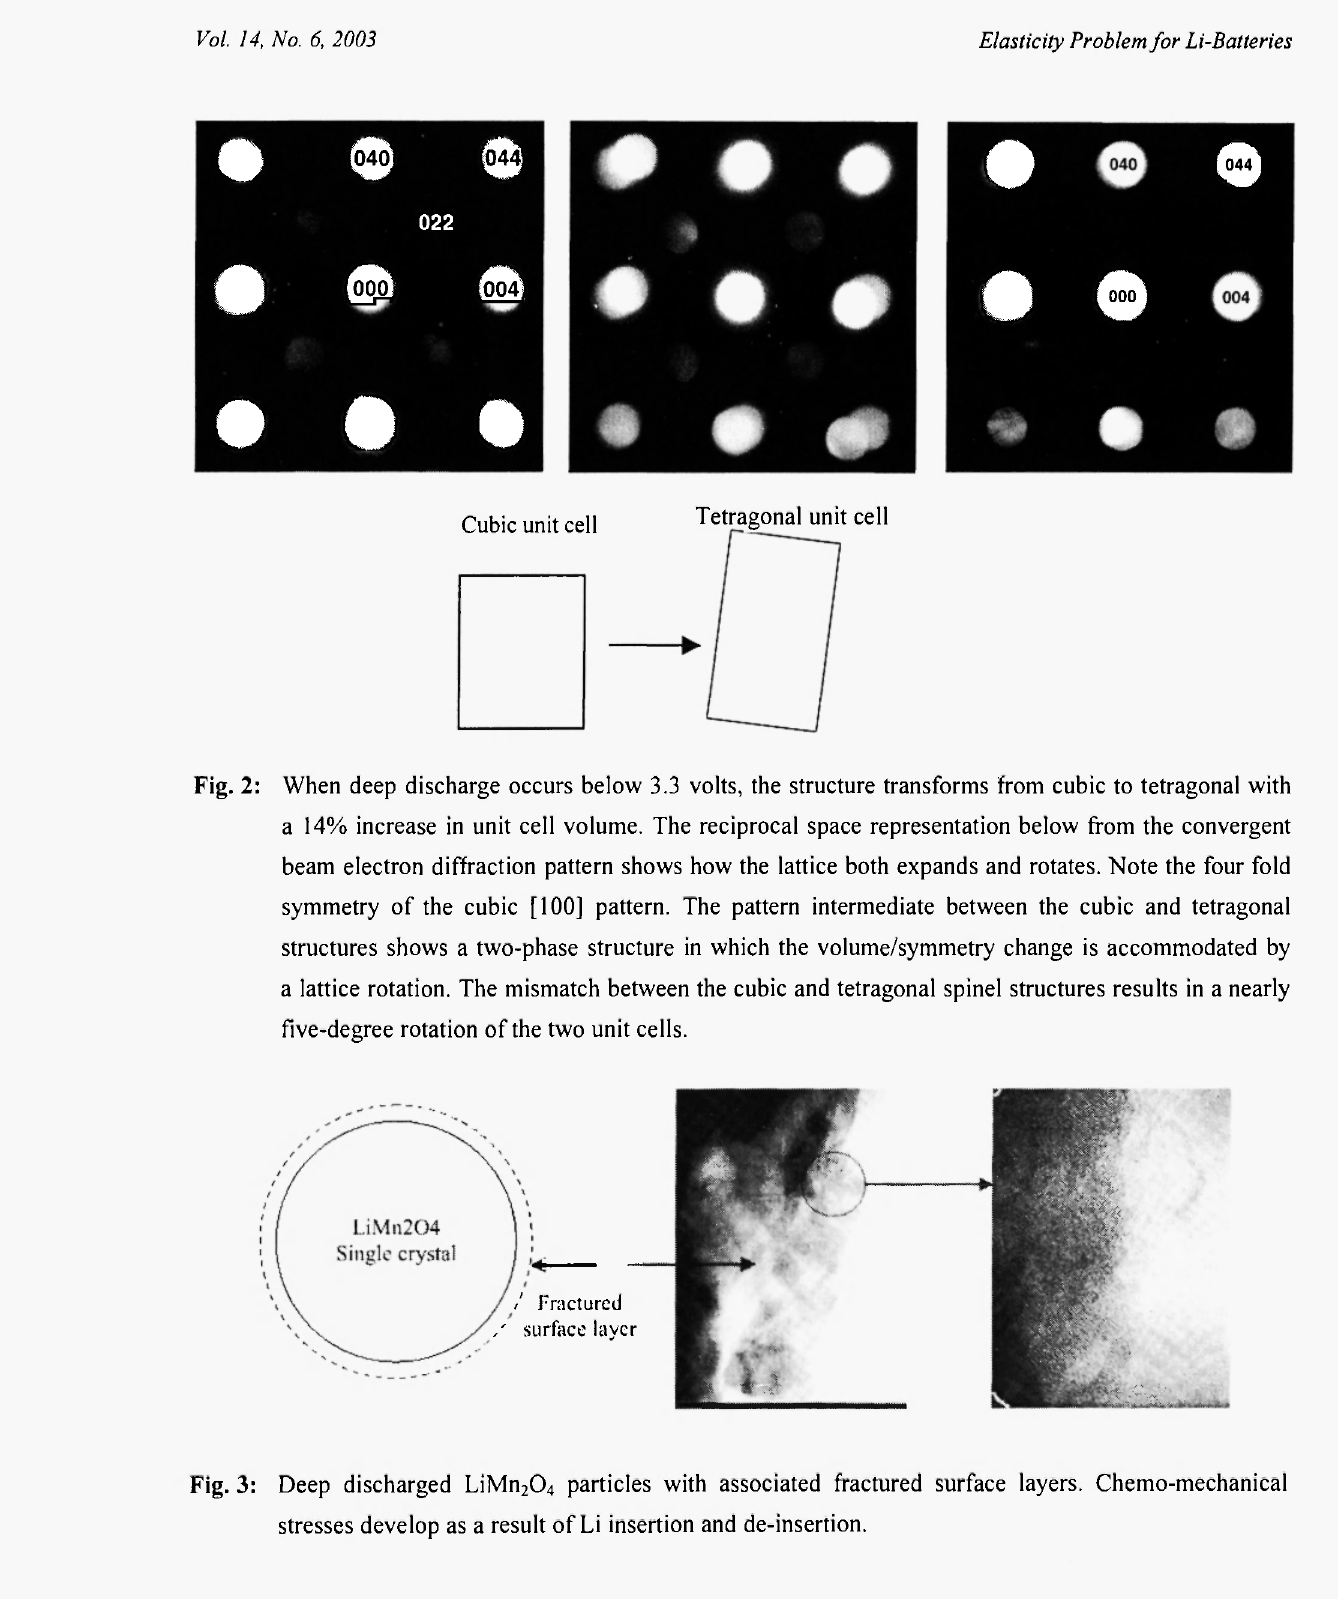
Fig. 3: Deep discharged LiMn 2 0 4 particles with associated fractured surface layers. Chemo-mechanical stresses develop as a result of Li insertion and